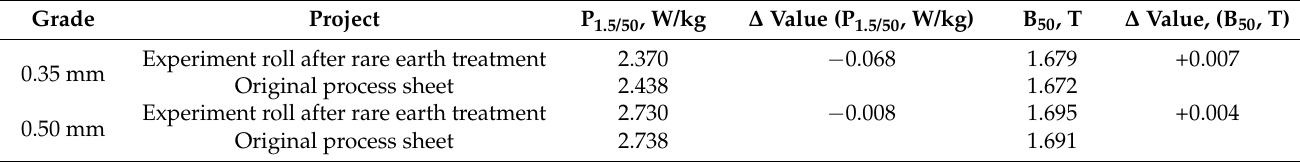
Figure 15. Size distribution of inclusions before and after rare earth treatment. ( a ) RE-free ( b ) RE-added. Table 4. Electromagnetic properties of the steel.